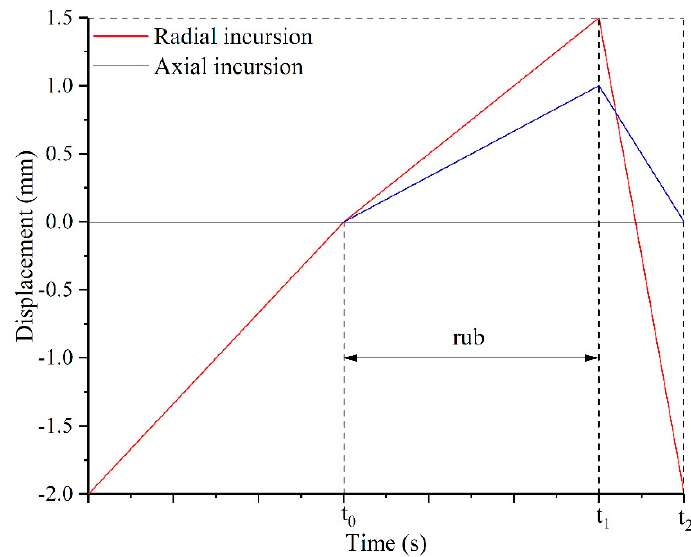
Figure 4. Typical incursion profile.